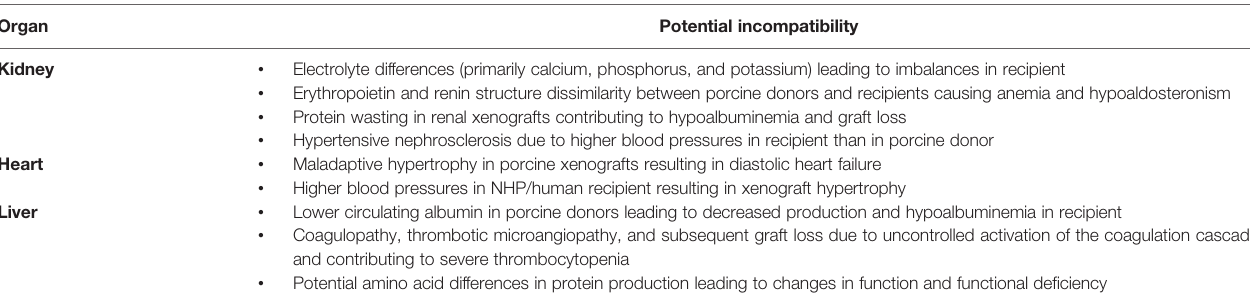
TABLE 1 | Potential physiologic incompatibility between xenograft and